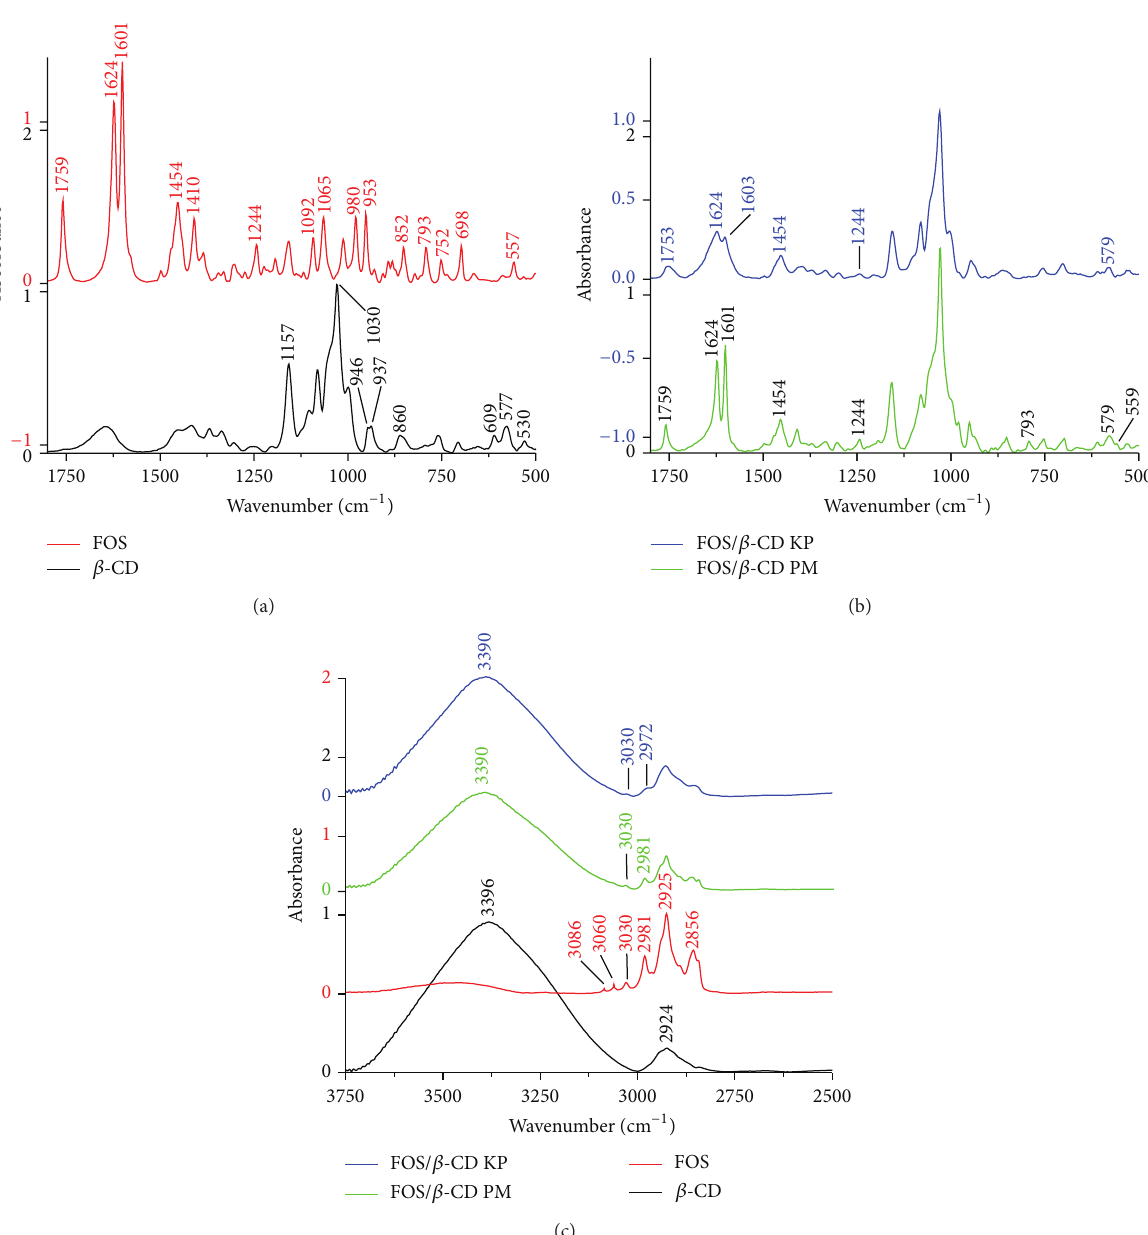
Figure 4: FTIR spectra of (a) FOS and 𝛽 -CD in 2000–500 cm −1 spectral region, (b) FOS/ 𝛽 -CD physical mixture and FOS/ 𝛽 -CD kneaded product in 2000–500 cm −1 spectral region, and (c) 𝛽 -CD, FOS, FOS/ 𝛽 -CD physical mixture and FOS/ 𝛽 -CD kneaded product in 4000– 2500 cm −1 spectral